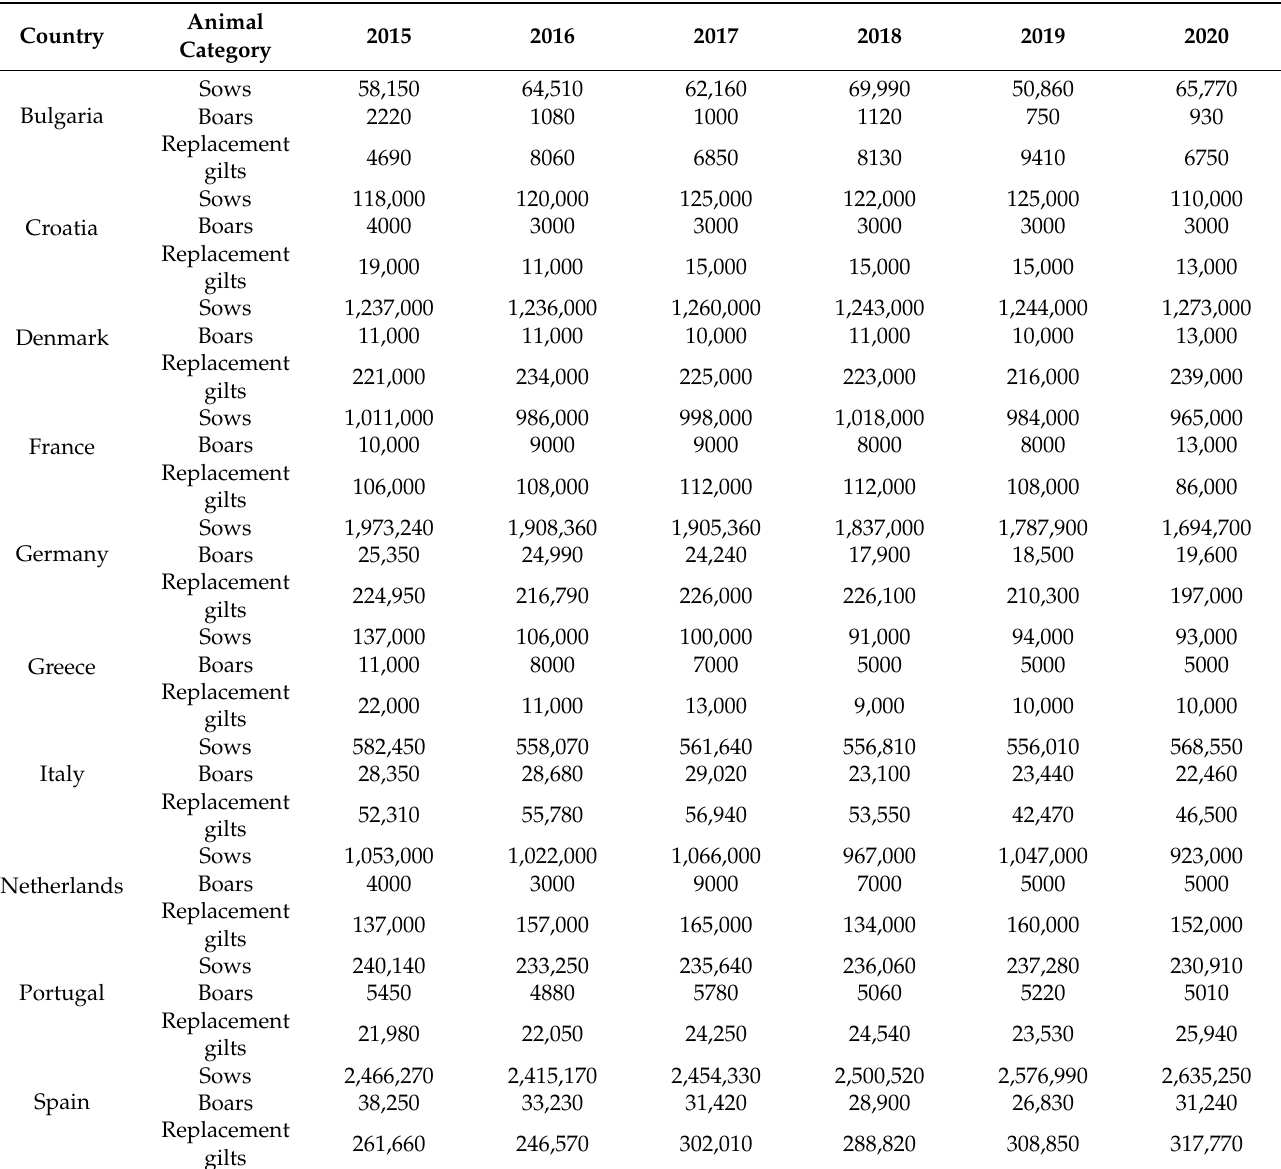
Table 2. Pig population per animal category in the studied European